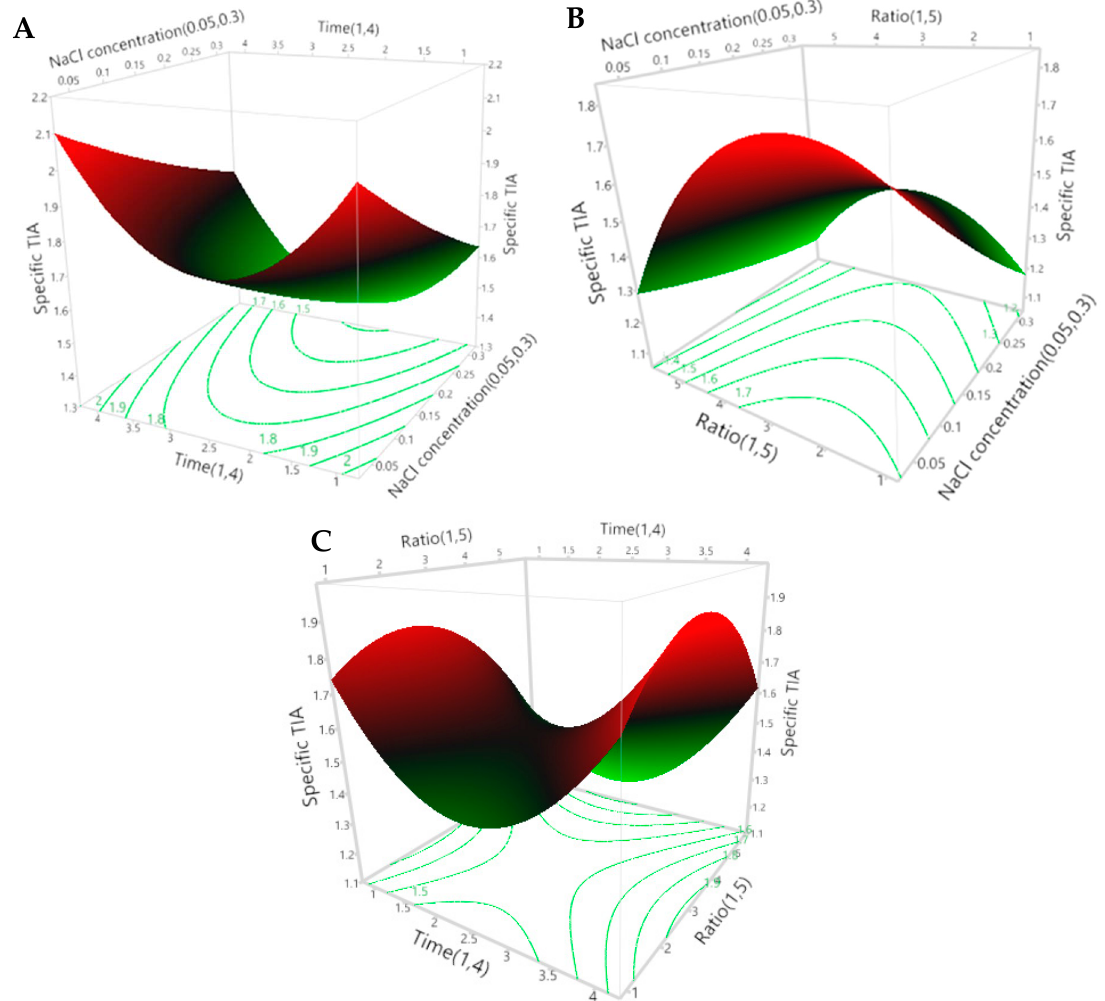
Figure 1. The 3D response surface and 2D contour plots for the specific trypsin-inhibitor activity (TIA) of the extracts. The effects of the NaCl concentration and the extraction time ( A ), the NaCl concentration and the ratio of defatted powder to solvent ( B ) and the extraction time and ratio of defatted powder to solvent ( C ) on the predicted specific TIA of the extracts are plotted according to the 2nd-order polynomial equation generated by the RSM (Equation 4).